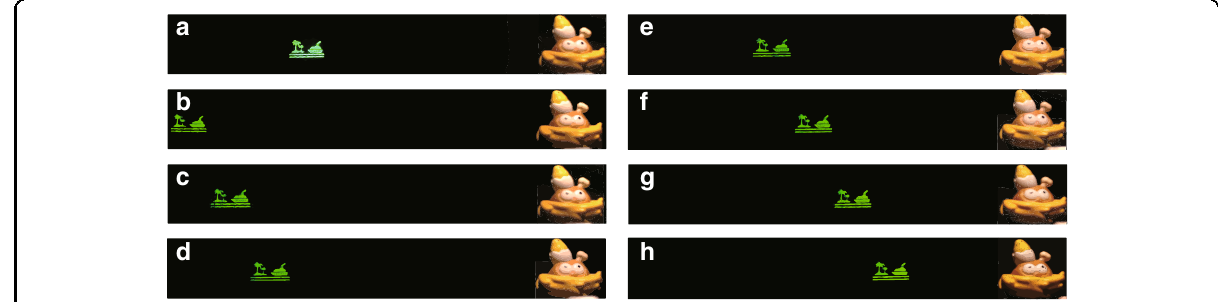
Fig. 7 Wide viewing reconstruction of 2D object. a Reconstructed image when no voltage is applied to the liquid crystal grating. b – h Reconstructed image having seven viewing